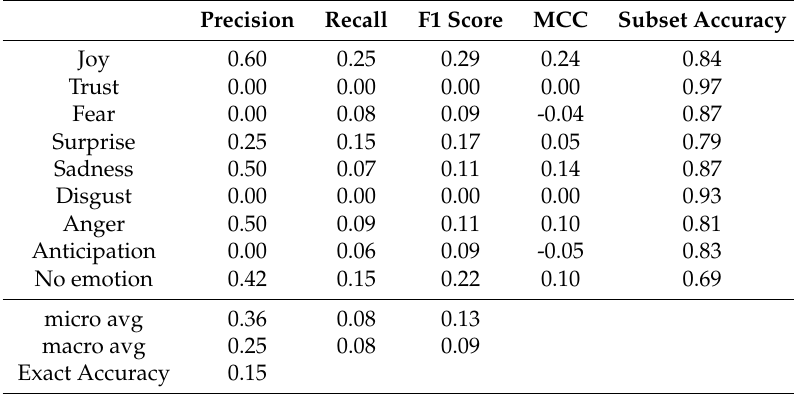
Accuracy of Term Frequency-Inverse Document Frequency (TF-IDF) representation, Multi-nomial Naive Bayes